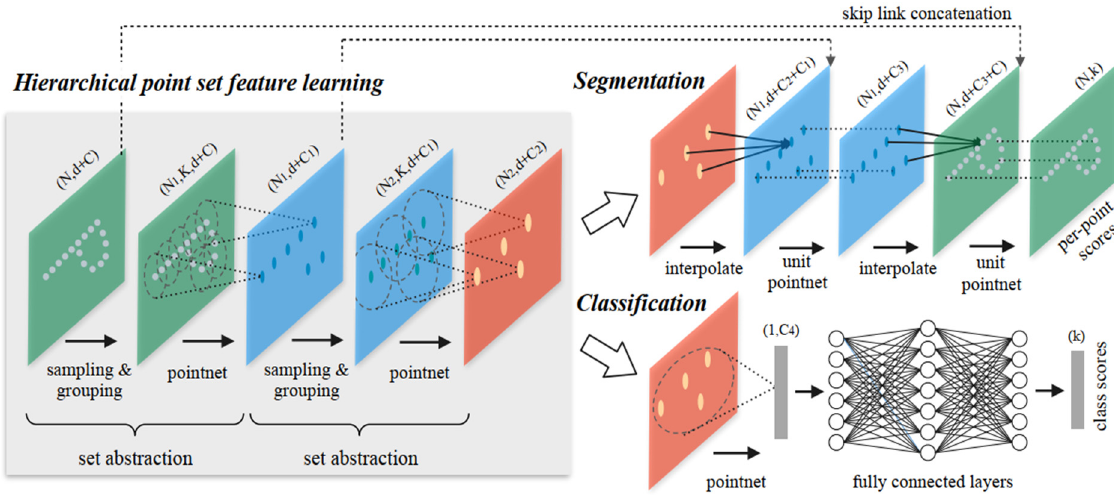
Figure 5. PointNet++ network architecture. Reprinted with permission from ref. [43], 2017, Cornell University.